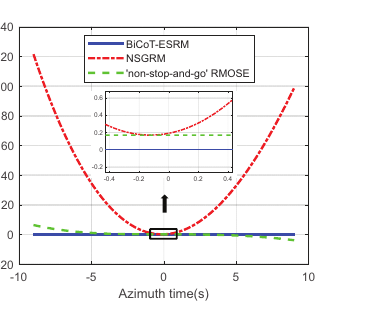
Figure 3. Bistatic range errors of the competing range models.